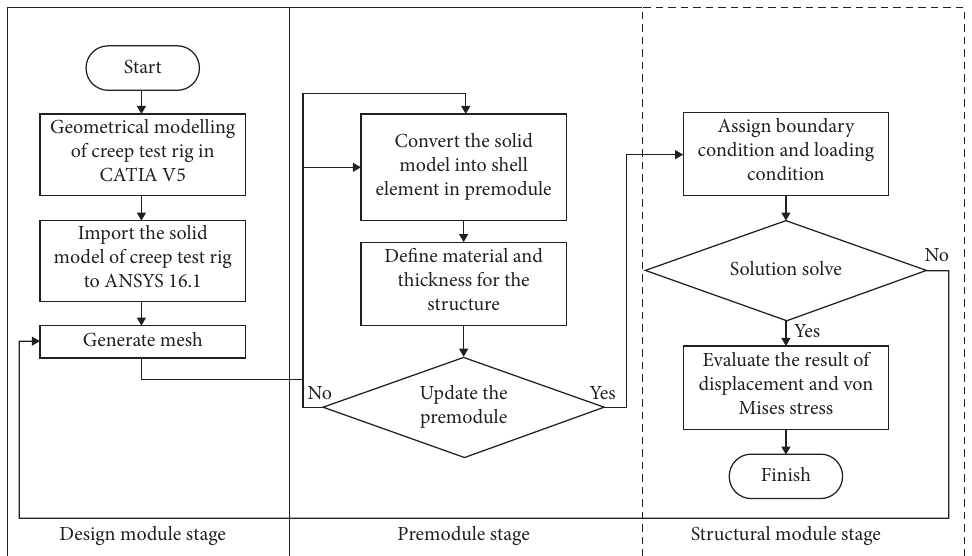
Figure 1: Flowchart of structural optimisation of creep test rig.